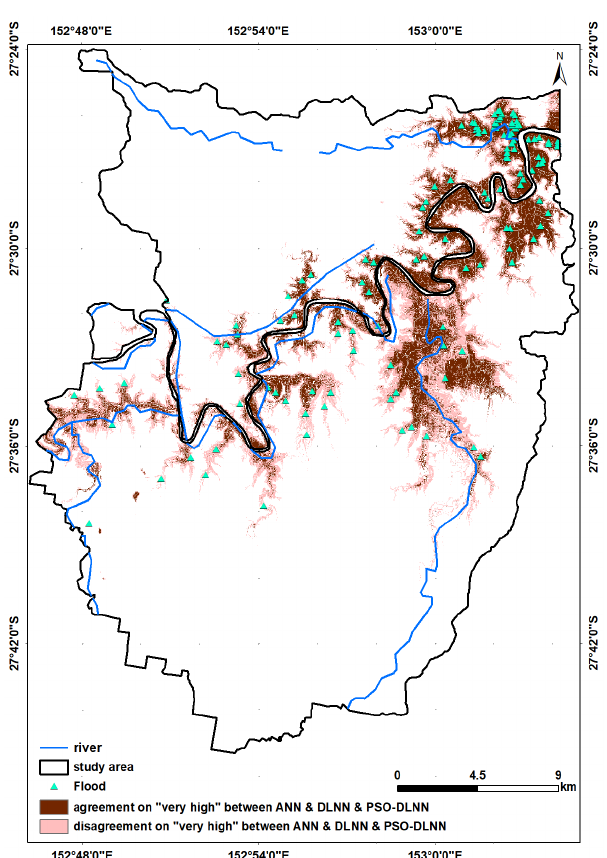
Figure 9. Agreement and disagreement flood susceptibility for the "very high" class simulated by ANN, DLNN, PSO-DLNN.